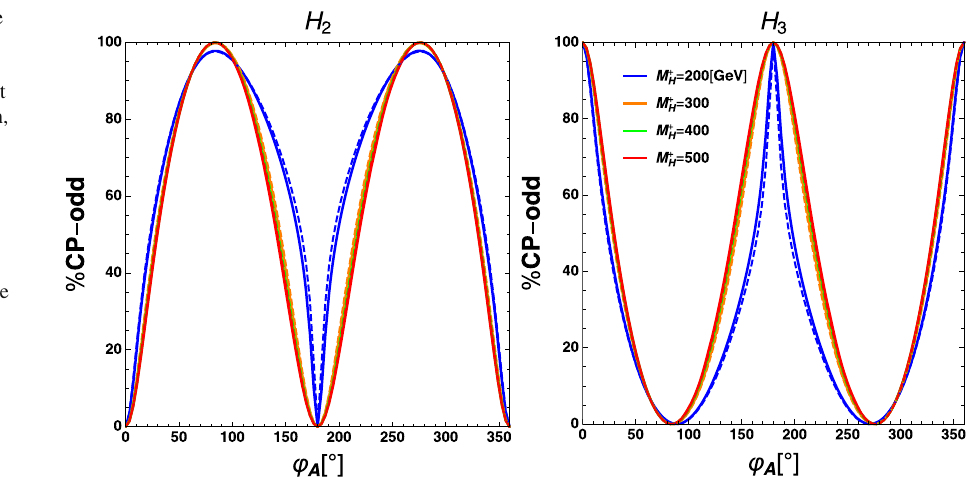
compared to a scenario where only the absolute values (and signs) but not the phases are included in the